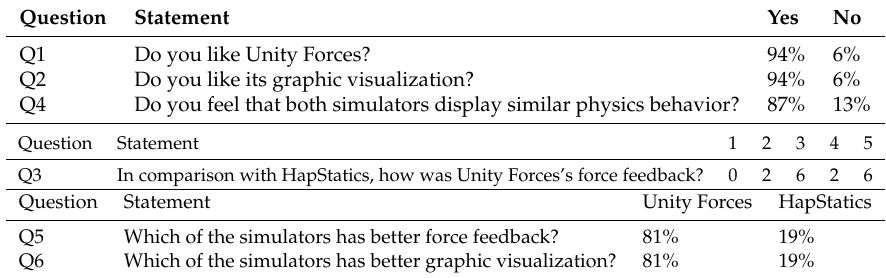
Table 5. Results of the perception questionnaire applied to participants after testing Unity Forces (N = 16).